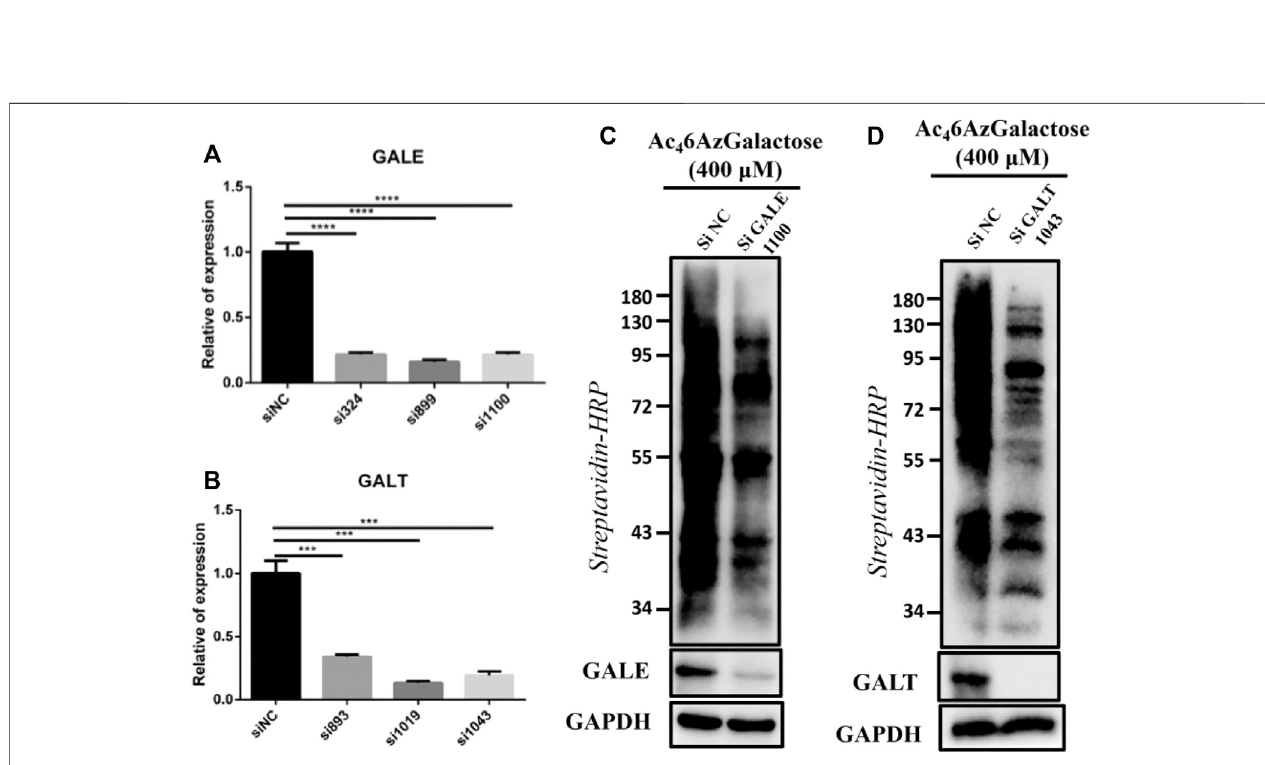
FIGURE 7 | Ac 4 6AzGal labels intracellular O-linked proteins rather than N-linked surface glycans. Ac 4 6AzGal signal is derived from O-linked glycoproteins.